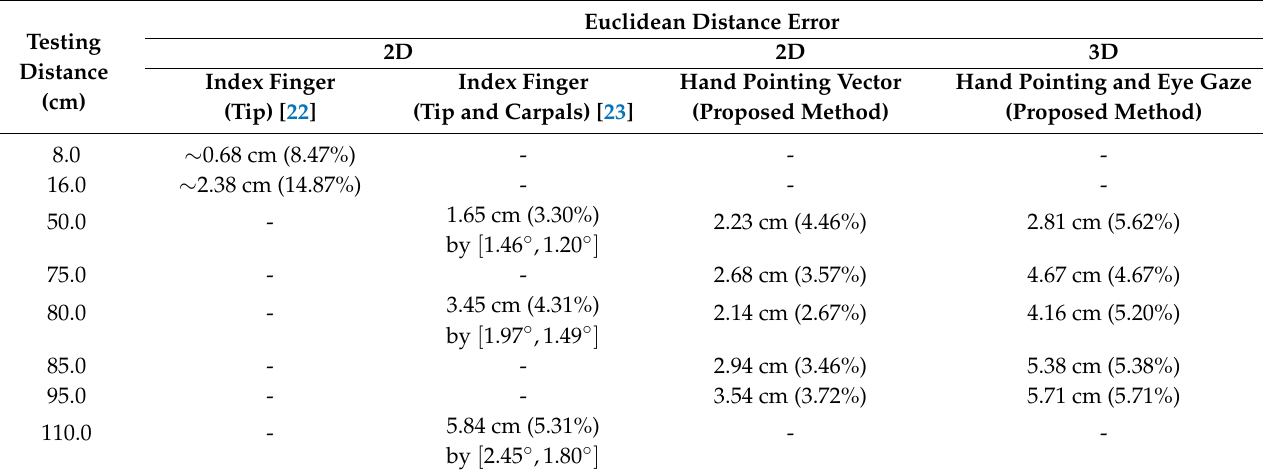
Table 5. Comparison of POI detection errors between conventional and proposed methods in 2D and 3D